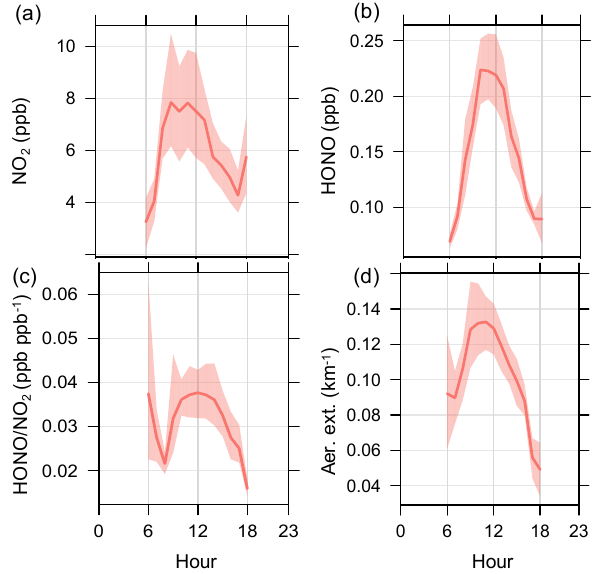
Figure 8. Data from 33 days in the measurement period with high daytime peak HONO. Diurnal cycle plots for the 1-hourly averages of (a) NO 2 , (b) HONO, (c) HONO / NO 2 and (d) aerosol extinction surface values at Broadmeadows. Solid line shows average values; shaded areas are 95% confidence intervals.